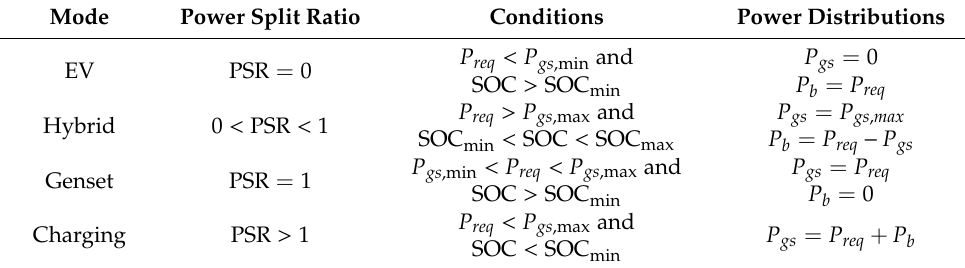
Table 2. Operation modes of